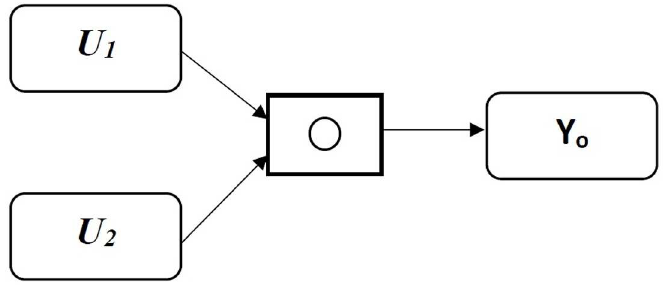
Fig 8. Analogical